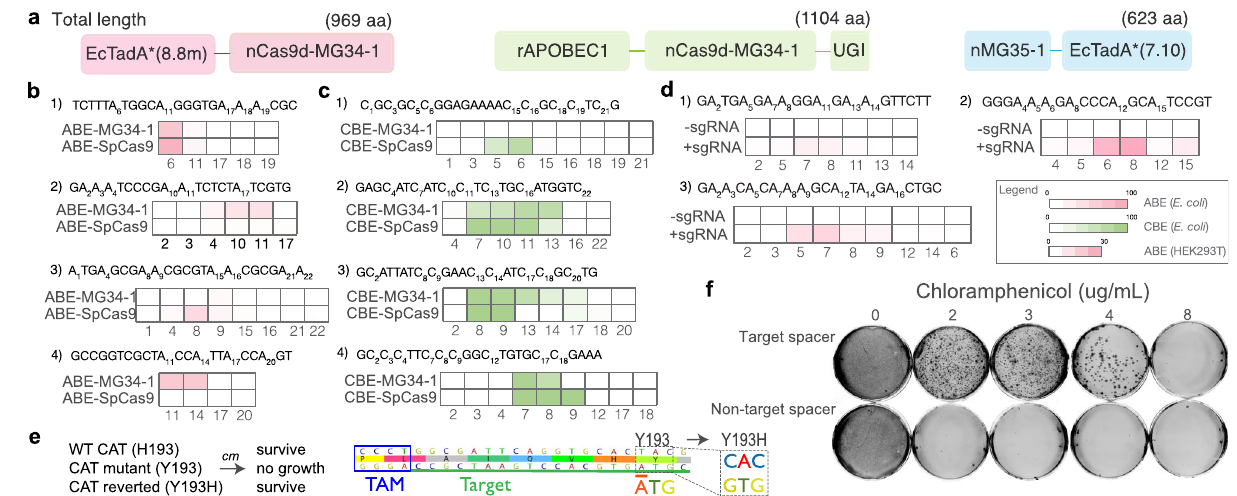
Fig. 4 | Base editing with engineered Cas9d-MG34-1 and HEARO MG35-1 nickases.a Diagramsofbaseeditorconstructswithtotalaminoacidlength(notto scale). b – d Base editing at multiple genomic target loci. Base editing in E. coli with ABE-MG34-1( b )andCBE-MG34-1( c )vs.referenceSpCas9baseeditorsatfourtarget loci. d BaseeditinginhumanHEK293TcellswithanABE-MG34-1(nickasefusedwith TadA*(8.8m)deaminase)atthreetargetloci.Thetargetsequenceforeachlocusin b – d is shown above each heatmap. Expected edit positions arerepresented on the sequence by a subscript number and at each position on the heatmap (squares). Heatmapsin b – d representthepercentageofNGSreadssupportinganeditateach position. Values in b and c represent the mean of two independent experiments, whilevaluesin d representthemeanofthreeindependentbiologicalreplicates. e E.